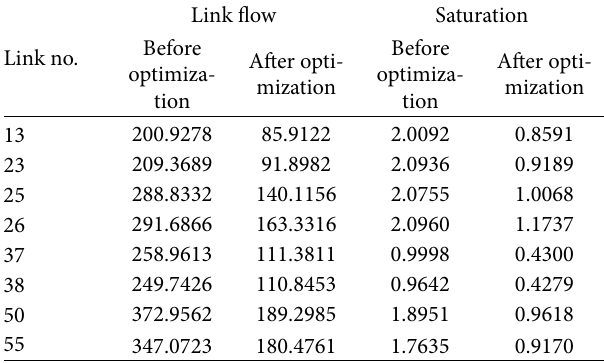
Table 5: Link flow and saturation on some links.